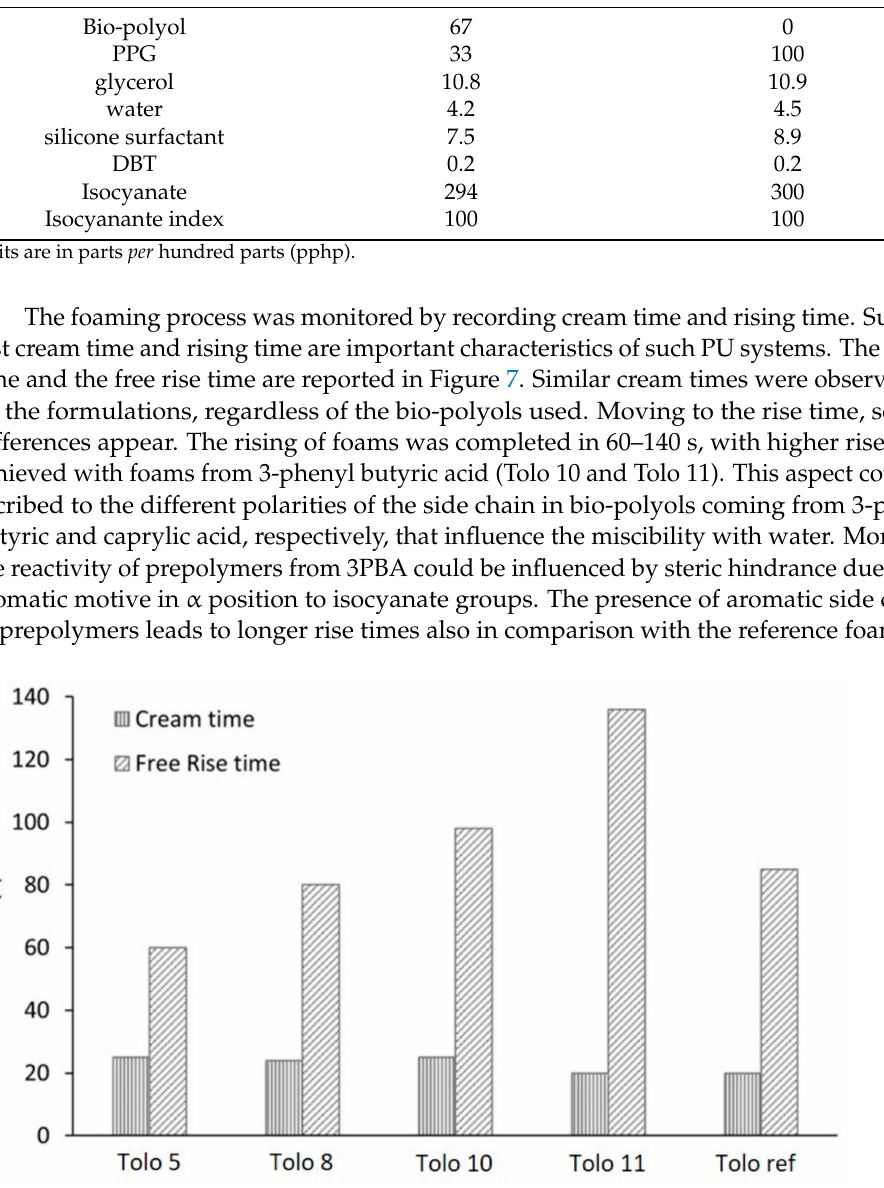
Figure 7. Effect of the different bio-polyols on cream and free rise